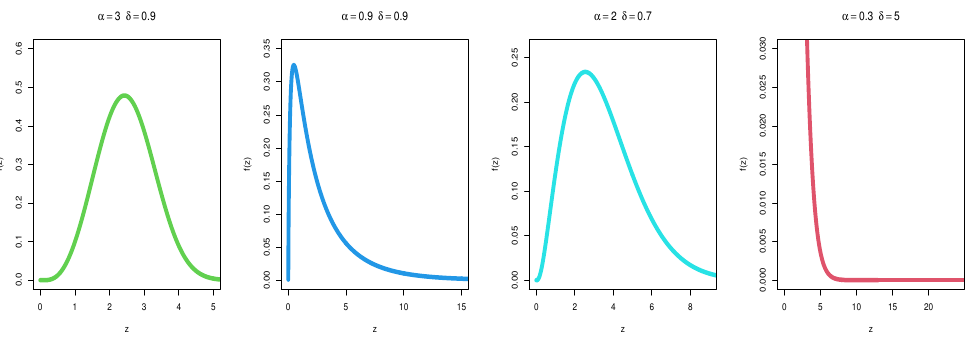
Figure 1. PDF of the MKITL distribution for certain parameter values.